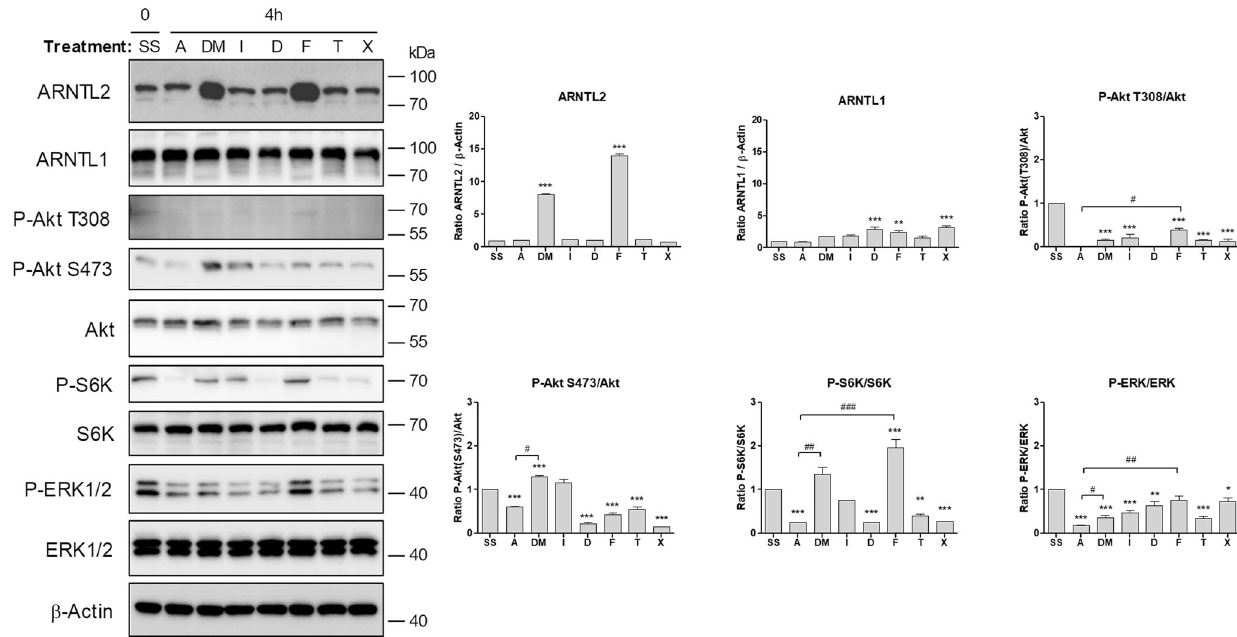
Fig. 4 Induction of ARNTL2 by differentiation medium (DM) and single compounds. Con fl uent ASCs were serum-starved (SS) followed by treatment with serum-free ASC1 medium (A), differentiation medium (DM), insulin (I), dexamethasone (D), FCS (F), transferrin (T) and IBMX (X) for 4 h. Left panel: a representative Western blot of n = 3 independent experiments (i.e., donors) is shown. PI3K/Akt/mTOR and MAPK signaling was analyzed to con fi rm activity of each compound used. β -Actin served as loading control. Right panel: densitometric analysis of the Western blot shown on the left. Values are presented as mean ± SEM of three measurements. Statistical comparison was done using One-way ANOVA and Dunnett´s Multiple Comparison Test (vs. SS; *) and the two-tailed paired/unpaired t test